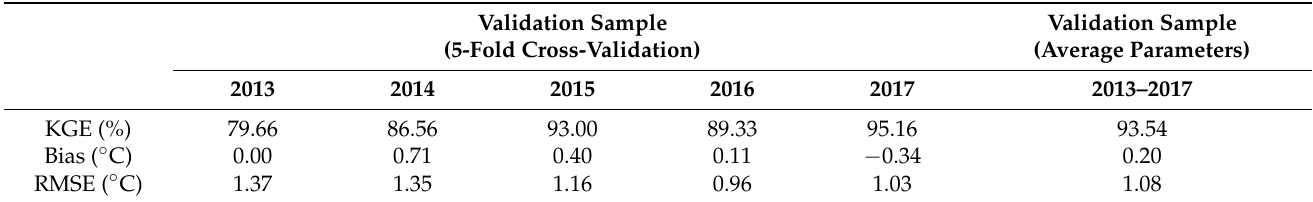
Table 2. Performance criteria for the simulated water temperature using a 5-fold cross-validation method and performance criteria using the average of the parameters obtained for the cross-validation calibration samples.